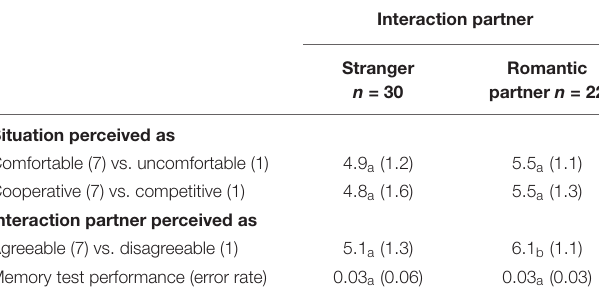
TABLE 1 | Means ( SD ) of participants’ ratings of the experimental situation and memory test